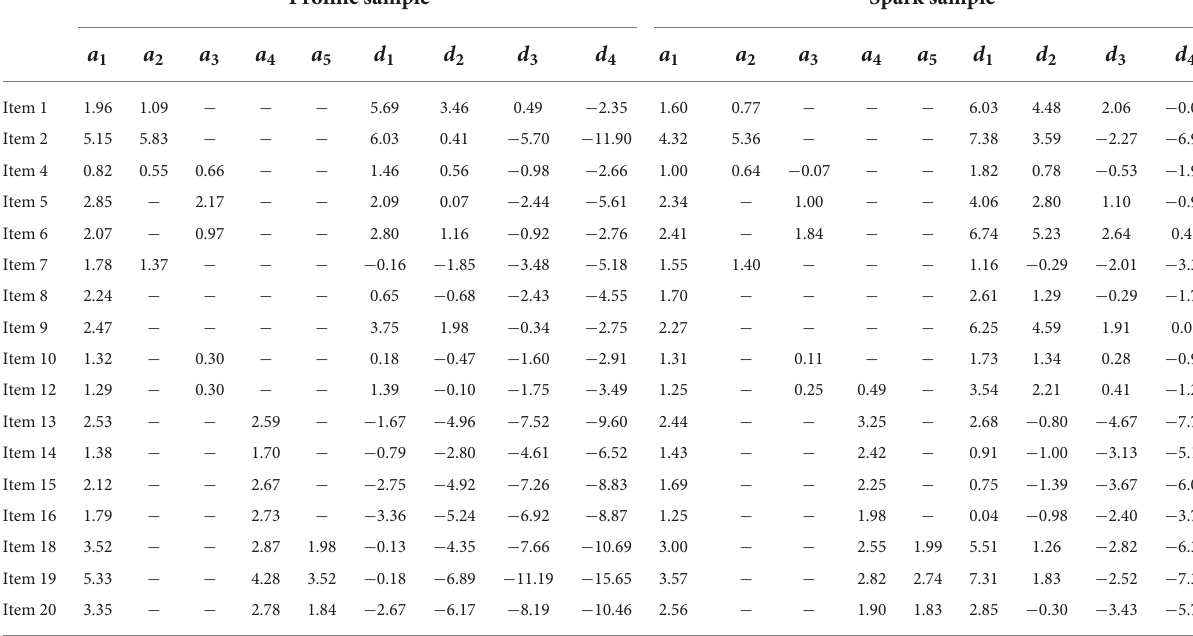
TABLE 5 Bifactor graded response model parameters for the final DVMSQ model in Prolific and SPARK samples. Prolific sample